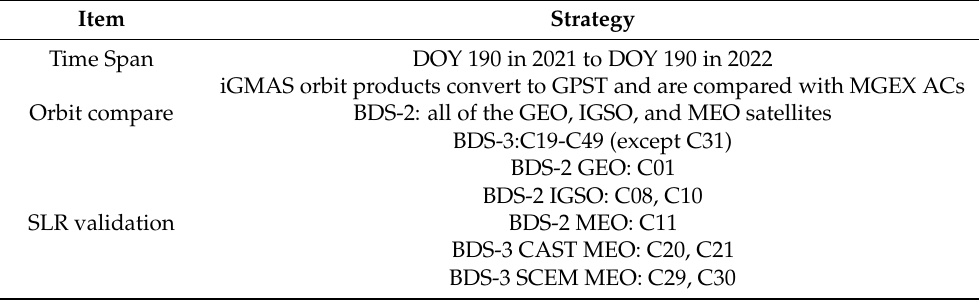
Figure 2. Availability of orbit products from iGMAS and four MGEX ACs . Table 2. Processing strategies of orbit products.